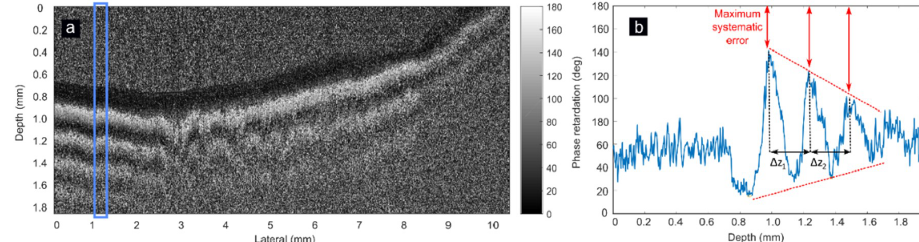
Figure 2. PS-OCT phase retardation image of one mitral chord specimen measured longitudinally ( a ). The average of A-scans marked with blue rectangle is shown in ( b ). A decay of phase amplitude is seen within depth (red dashed lines). Difference between 180 deg and empirical curve amplitude is indicative of maximum systematic error (red arrows). The period between phase retardation peaks ( ∆ z 1 and ∆ z 2 ) is constant within depth (black arrows), not being affected by amplitude variations of the phase